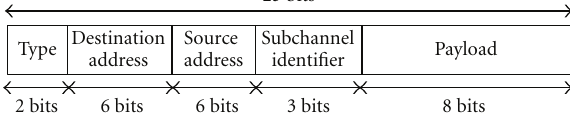
Figure 7: Best-e ff ort packet format TDM-based